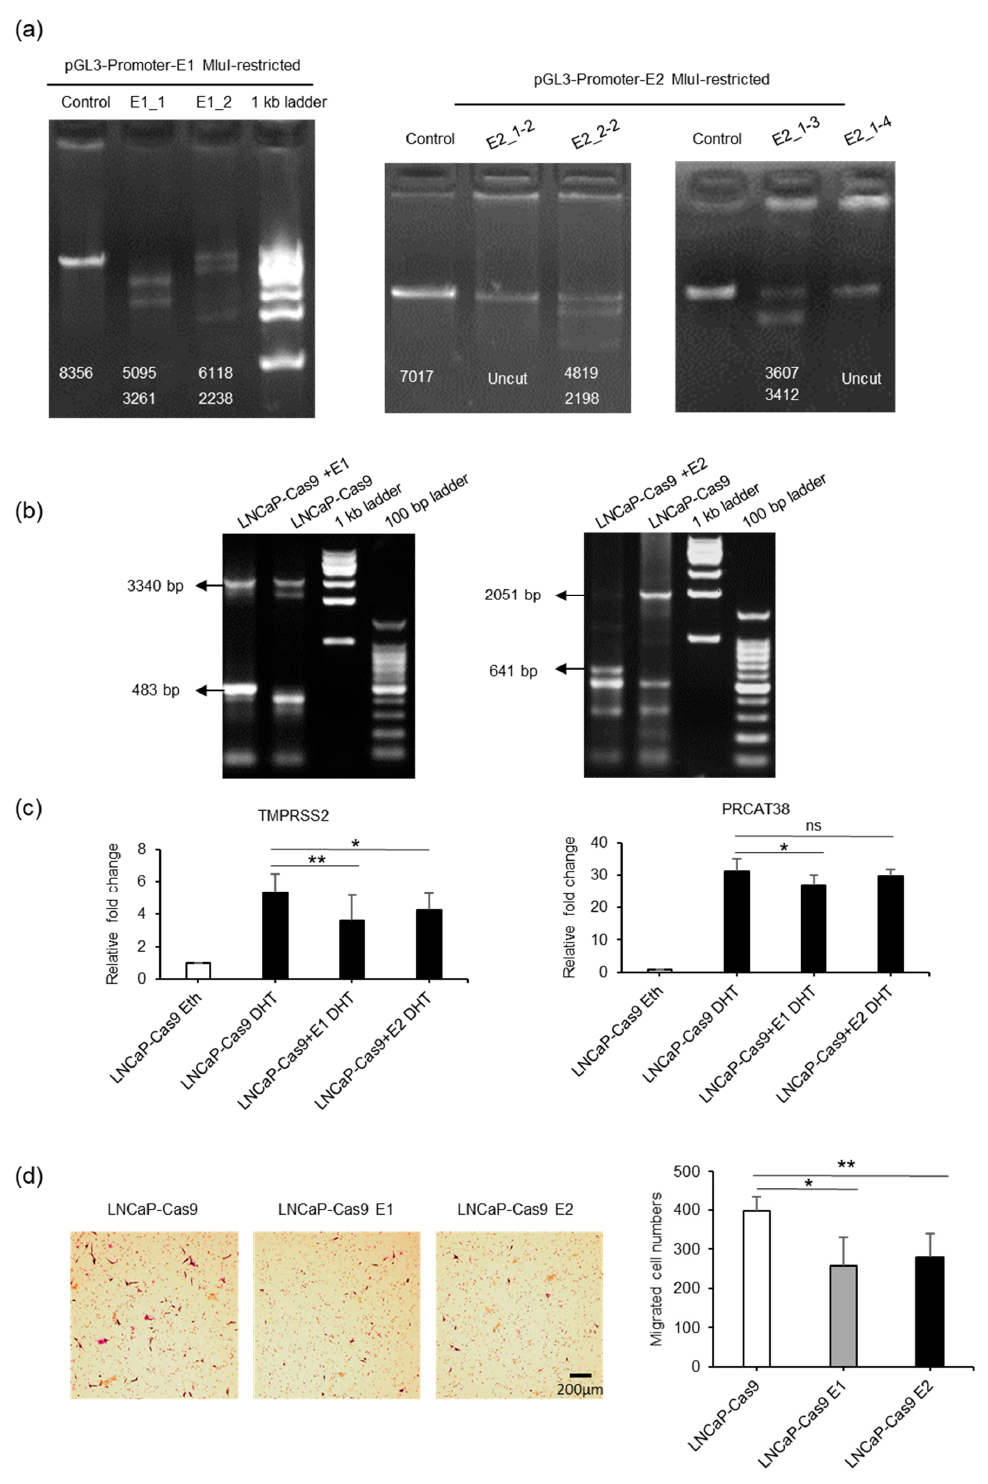
Figure 4. Knockout of enhancer E1 or E2 downregulates the transcription of TMPSS2 and PRCAT38 . ( a ) Determination of the e ffi cacy of sgRNAs using MluI-restricted plasmids as templates in a cell-free system (Figure S4A). Numbers on the gel pictures indicate the expected size of the products after Cas9-mediated DNA digestion. ( b ) Determination of e ffi cacy of sgRNAs after transfection of dual-sgRNA plasmids into LNCaP-Cas9 cells. The numbers on the gel pictures indicate PCR products before and after knockout. ( c ) Knockout of enhancer E1 or E2 in a subpopulation of cells downregulates TMPRSS2 and PRCAT38 transcription after DHT treatment. ( d ) Knockout of enhancer E1 or E2 impairs the migration of LNCaP cells. Data are shown as the mean ± SD (n = 3), *: P < 0.05, **: P < 0.01, ns: not